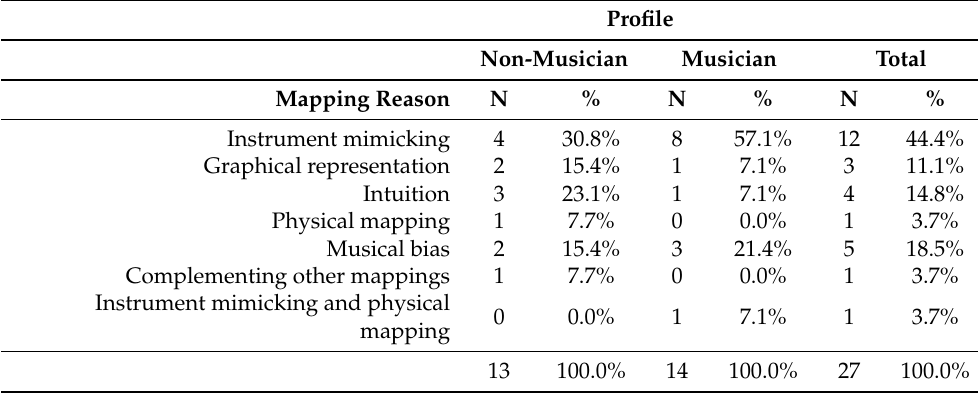
Table A22. Mapping rationale—stimulus a.